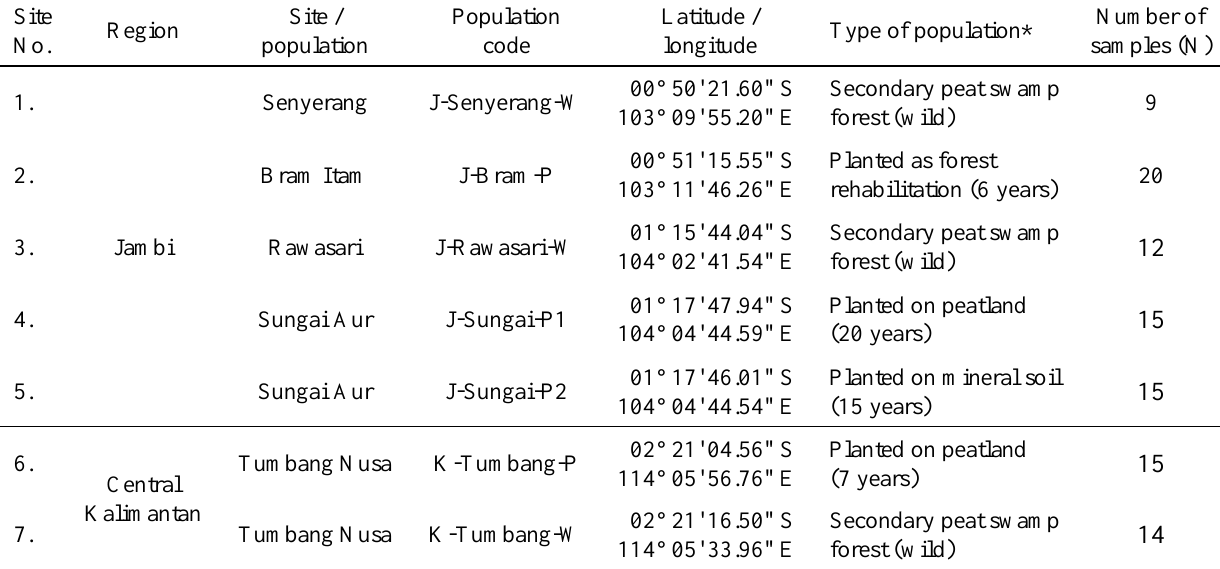
Figure 1. Locations of the study areas in the provinces of Jambi (on the island of Sumatra) and Central Kalimantan (on Borneo), with natural plus man-made drainage indicated. Table 1. Locations of leaf sample collections from the seven D. polyphylla populations. The population code prefix indicates the province (J=Jambi, K=Central Kalimantan) and the suffix distinguishes wild (W) from planted (P) populations (two at J-Sungai). Sites 1–5 are described in more detail by Tata et al. (2016). Site No.